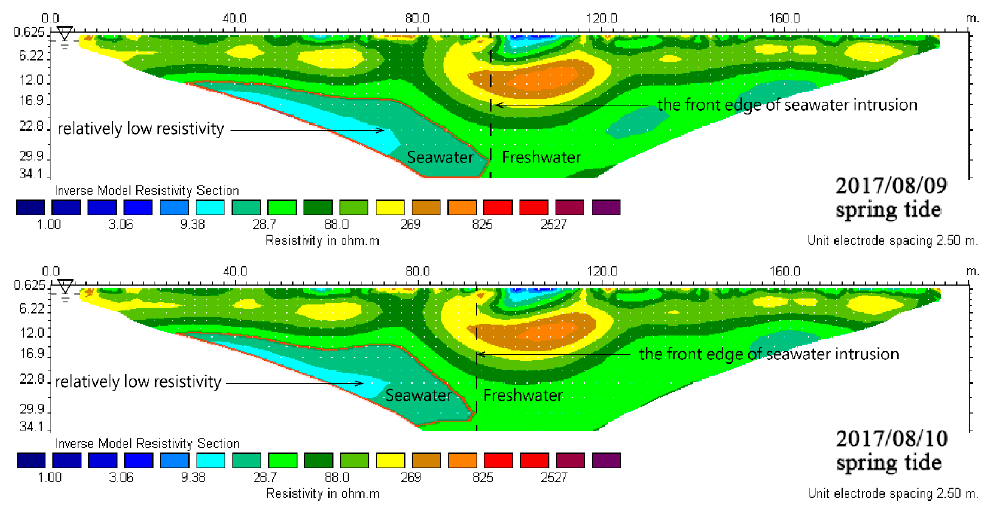
Table 3. Water quality sampling